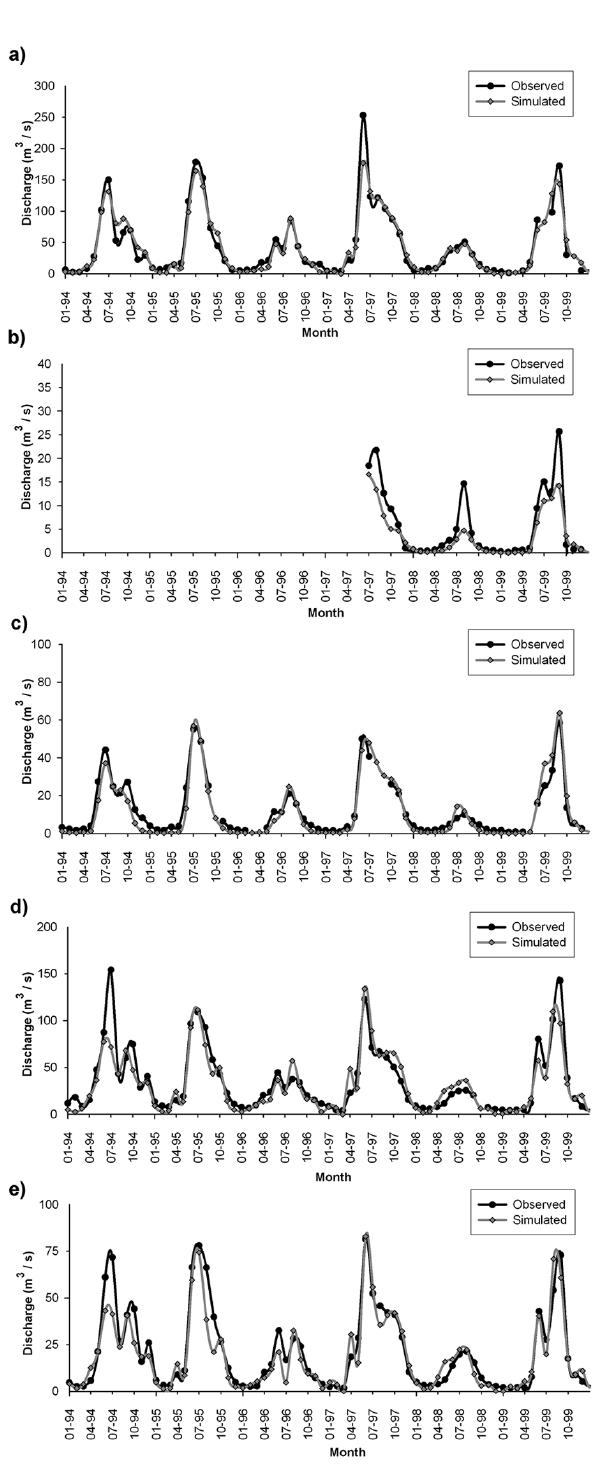
Fig. 10. Observed and simulated monthly discharges for the years 1994–1999 at gauge stations Tijeral (a) , Rehue (b) , Mininco (c) , Renaico (d) and Malleco (e) .